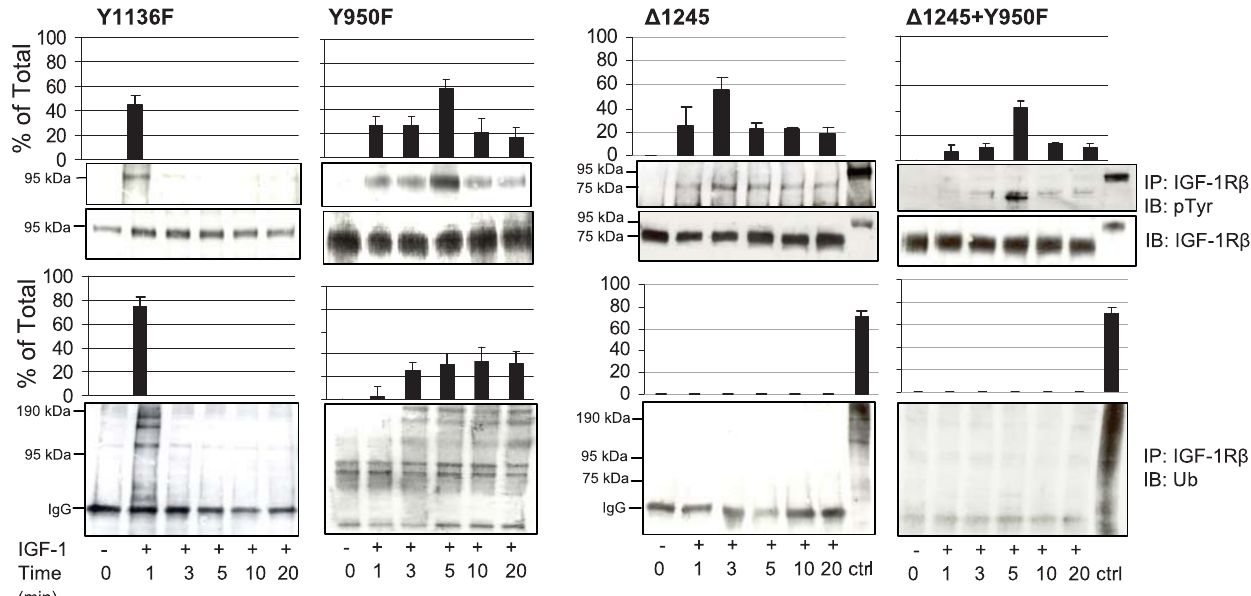
Figure 3. C-terminal domain is essential for ubiquitination of IGF-1R. After 24-h serum starvation Y1136, Y950F, D 1245 and Y950F- D 1245 cells were stimulated for the indicated time points with IGF-1. Determinations of IGF-1R phosphorylation and ubiquitination were performed as described in Fig. 2. The investigated signals from three independent experiments were quantified (% of loading control) and presented in graphs above each blot. Means and SDs are shown.